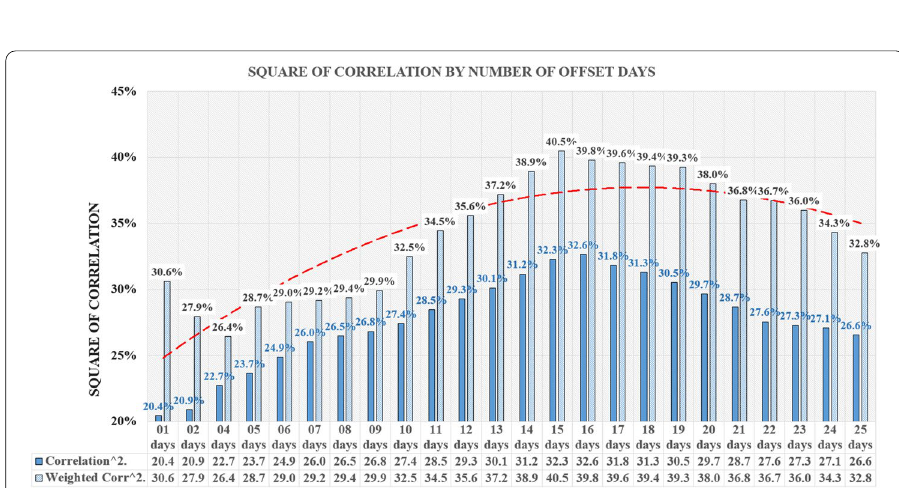
Fig. 7 Square of correlation by number of offset days—first 150 days of